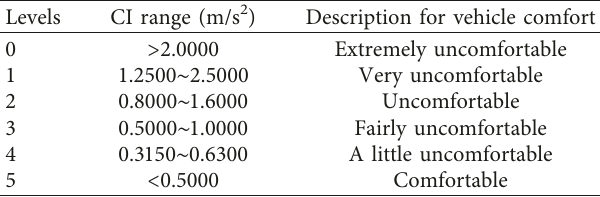
Table 1: Comfort evaluation level for autonomous